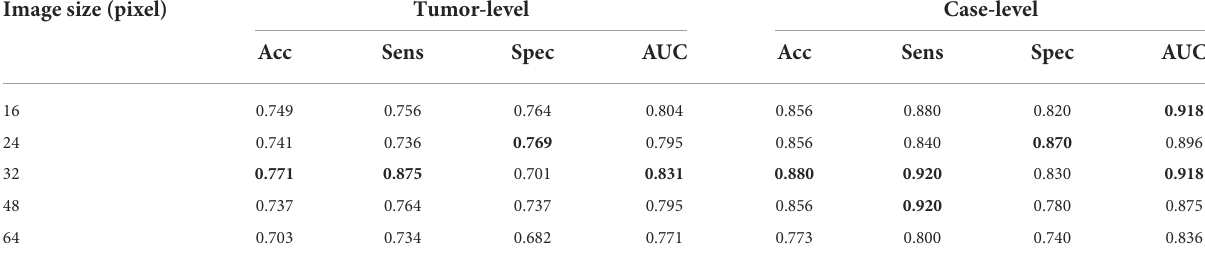
TABLE 4 Evaluations of tumor images at different sizes.